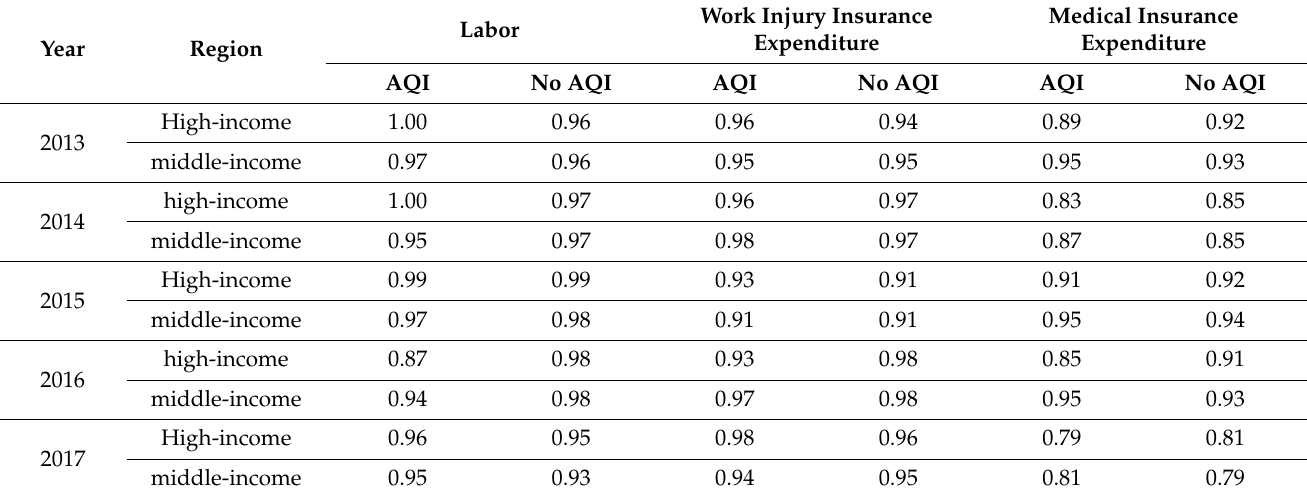
Table 3. Input variables from 2013–2017 between high- and upper-middle-income regions. Work Injury Insurance Medical Labor Expenditure